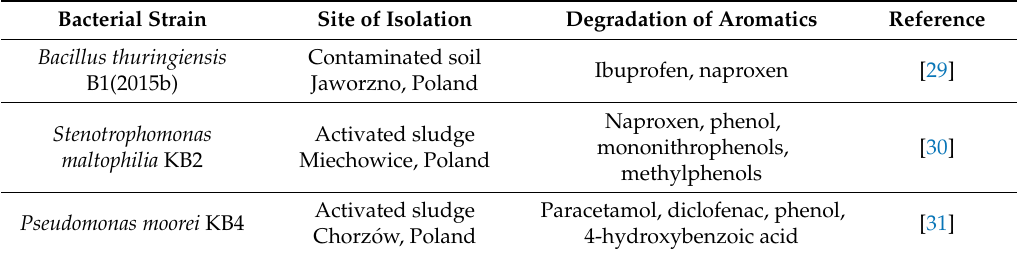
Table 2. Composition of the bacterial consortium for bioaugmentation of the